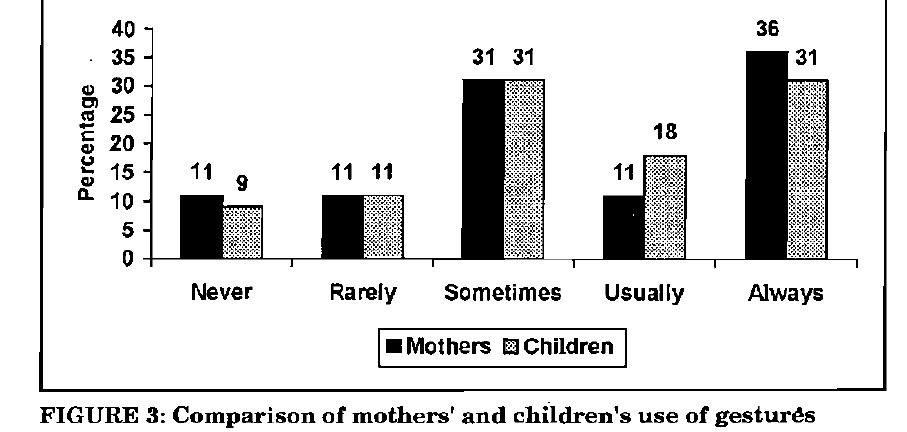
FIGURE 3: Comparison of mothers' and children's use of